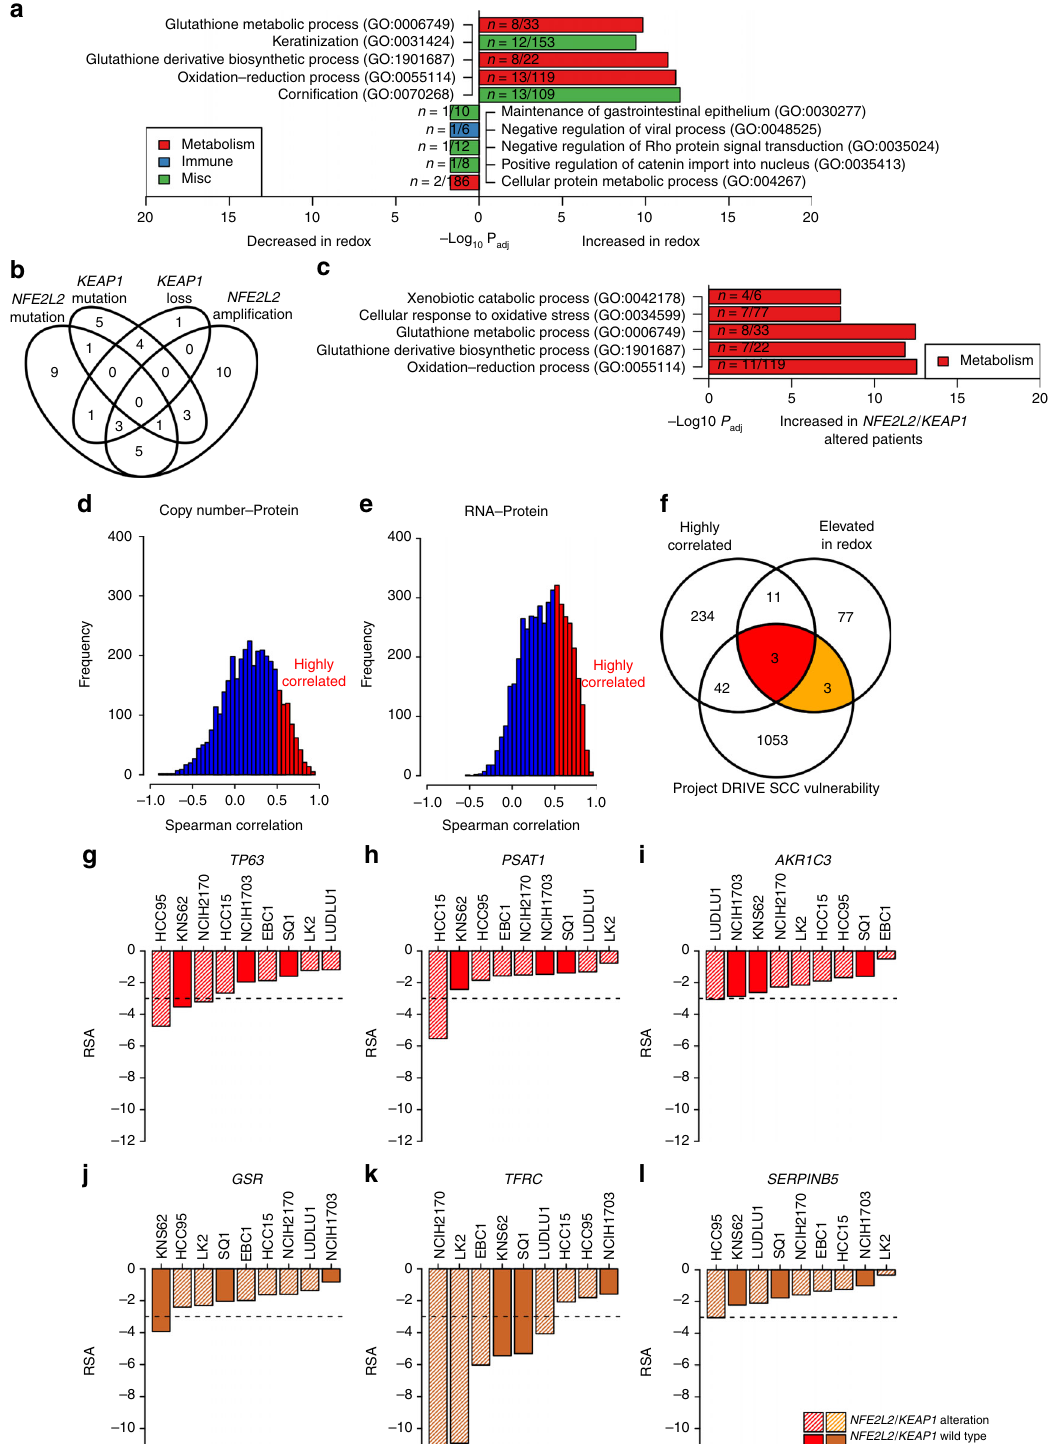
Fig. 5 The Redox subtype is enriched for oxidative stress pathways and NFE2L2/KEAP1 alterations. a Pathway enrichment of signi fi cantly different proteins (±1.5 fold-change and Wilcoxon P adj ≤ 0.05 compared to the rest of the cohort). The Redox subtype was enriched for oxidation-reduction and keratinization pathways. b 43 Redox samples (84%) had at least one genomic alteration of NFE2L2 or KEAP1 . c Stratifying patients by NFE2L2 or KEAP1 mutation ( NFE2L2 / KEAP1 wild type patients vs. NFE2L2 mutant and KEAP1 mutant patients) revealed enrichment of oxidation-reduction and xenobiotic metabolism pathways in NFE2L2 / KEAP1 -altered patients (Enrichr). d , e We used DNA copy number to protein correlation >0.5 and correlation of RNA to protein >0.5 to identify 290 genes for subsequent analysis. f Highly correlated genes were intersected with signi fi cantly elevated proteins from the Redox subtype and genes that adversely impacted SCC viability in the Project DRIVE shRNA screen. g – l Project DRIVE screen results for squamous cell lung cancer cell lines. RSA < − 3 is considered signi fi cant. Bar plots represent individual